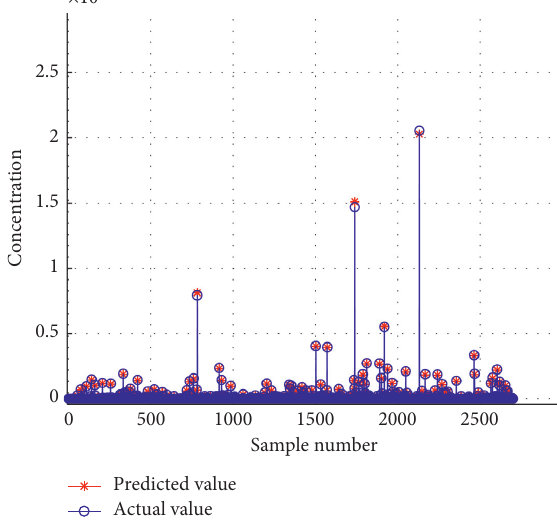
Figure 13: The Weihai test set data prediction effect